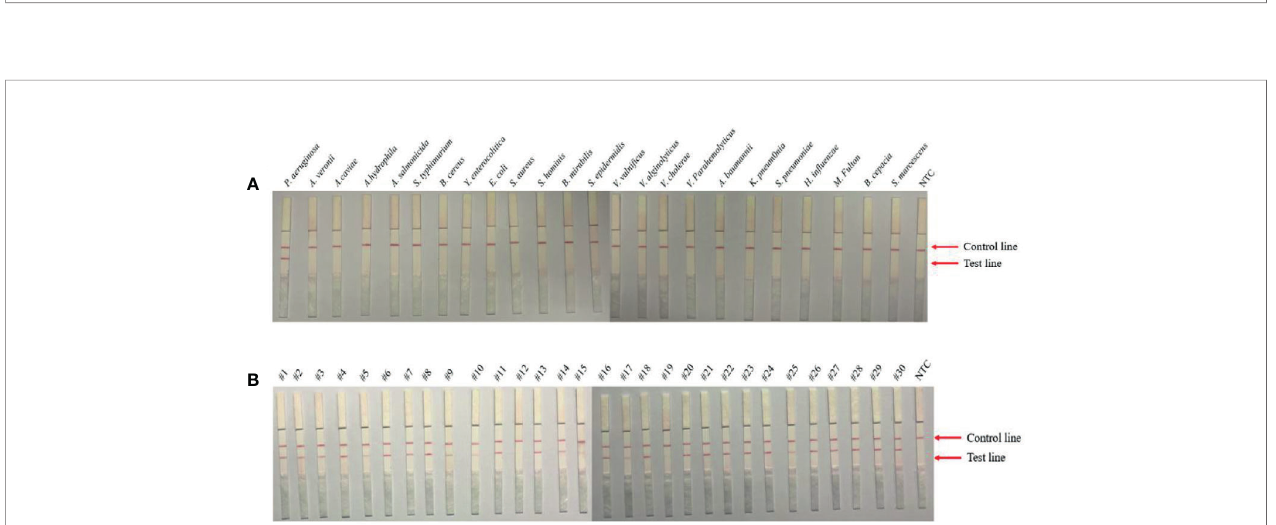
FIGURE 3 | Speci fi city analysis of P. aeruginosa RPA-LFS assay. The speci fi city of the established RPA-LFS detection system for P. aeruginosa was tested using genomic DNA extracted from 9 common respiratory bacterial pathogens or 14 food-borne or water-borne bacterial pathogens (A) and 28 clinical isolates of P. aeruginosa (B) . A no template control (NTC) was used as the negative control, and P. aeruginosa was used as the positive control. RPA ampli fi cation results were detected using LFS and samples are indicated on the top of the